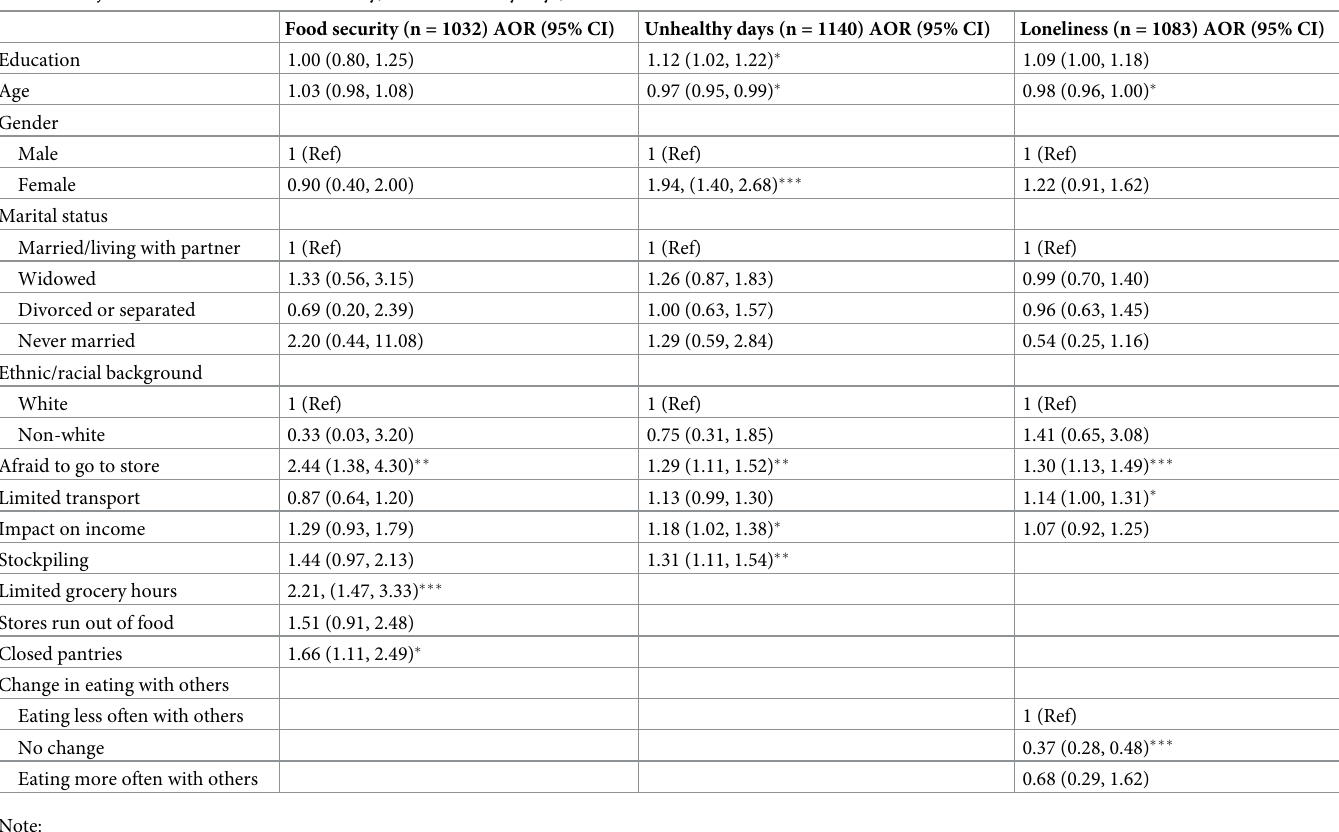
Table 3. Adjusted odds of worse food security, more unhealthy days, and more